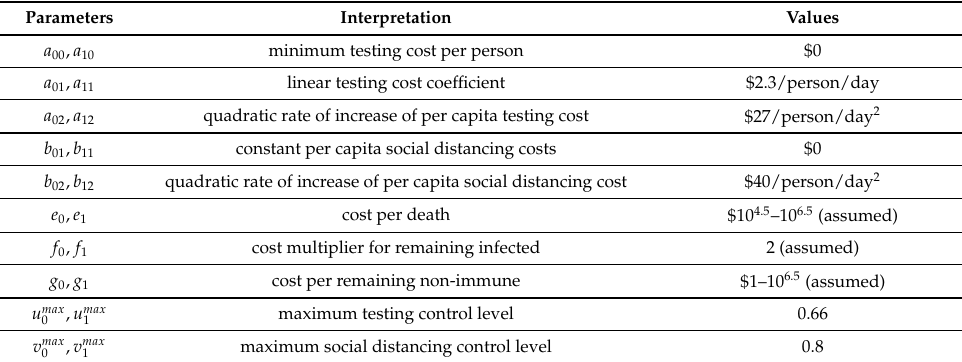
Table 2. Cost coefficients and level parameters used in